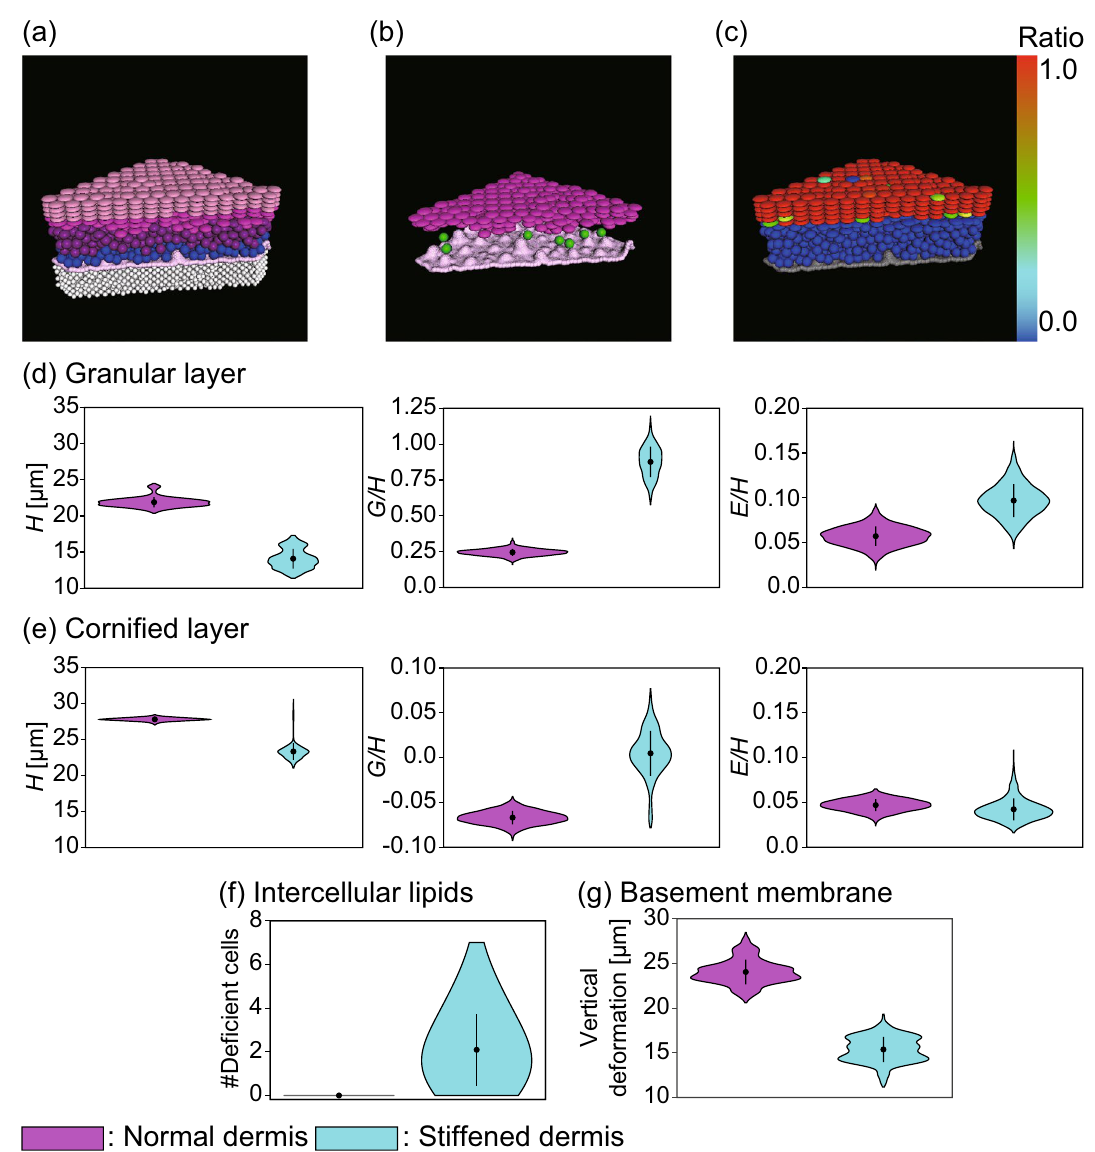
Figure 4. The effect of dermal stiffness. ( a – c ) Simulation with the stiffened dermis, presented in the same way as in Figs. 1( a – c ) and ( d – g ). Comparison of the evaluation functions between the normal dermis and the stiffened dermis. ( d ) Evaluations of thickness H , normalized dispersion G / H , and normalized spatial variation E / H for the granular layer. ( e ) H , G / H , and E / H for the cornified layer. Note that the vartical scales for G / H are different between ( d ) and ( e ). ( f ) Number of cells with inadequate lipid production (less than 50% of the maximum). ( g ) Amplitude of the basement membrane deformation, defined by the difference between the maximum and minimum vertical displacements. Each violin plot contains 4001 data points within simulation time span T = 280 days (approximately 10 turnovers). Mean values and standard deviations are shown by black dots and black vertical lines,